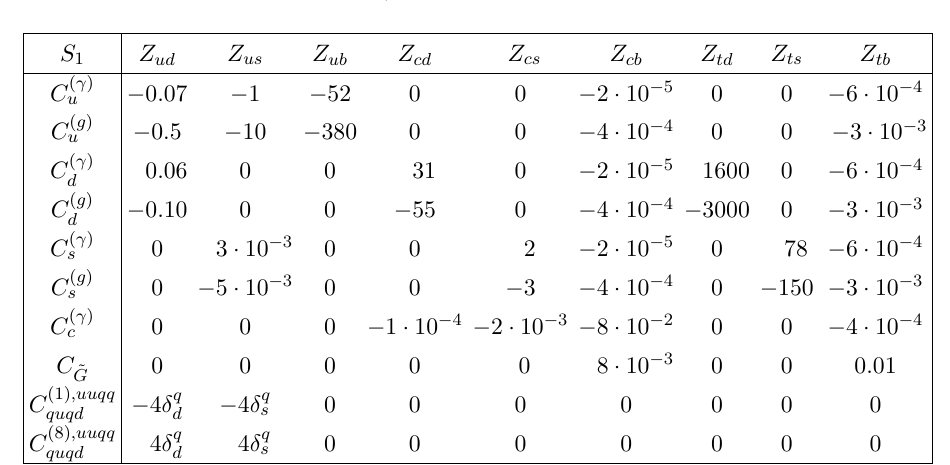
Table 1 . Dependence of the low-energy CP-odd Wilson coe(cid:14)cients in eqs. (3.1), (3.20), and (3.21) on the X lq couplings for m LQ = 1 TeV. All low-energy couplings were evaluated at (cid:22) = 1 GeV apart from C ( (cid:13) ) c which was evaluated at (cid:22) = m c .